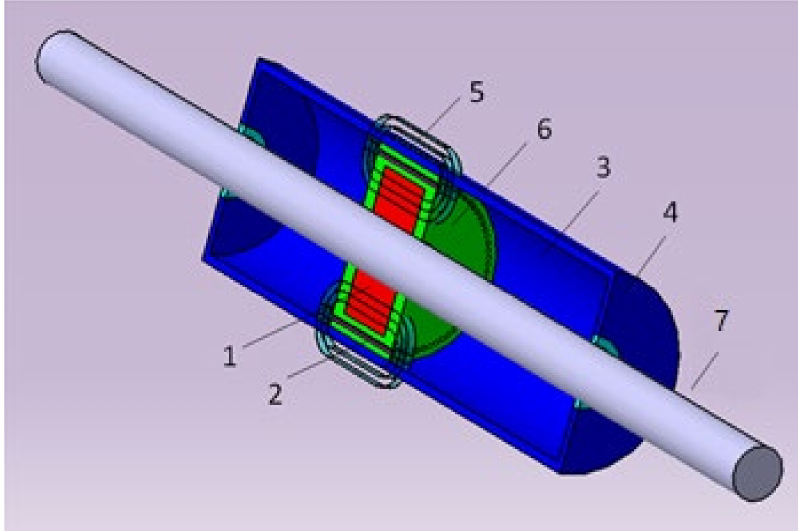
Figure 1. Diagram of the magnetorheological MR-IP damper: 1—coil, 2—orifices, 3—magnetorheological fluid, 4—housing, 5—magnetic field, 6—piston, 7—piston